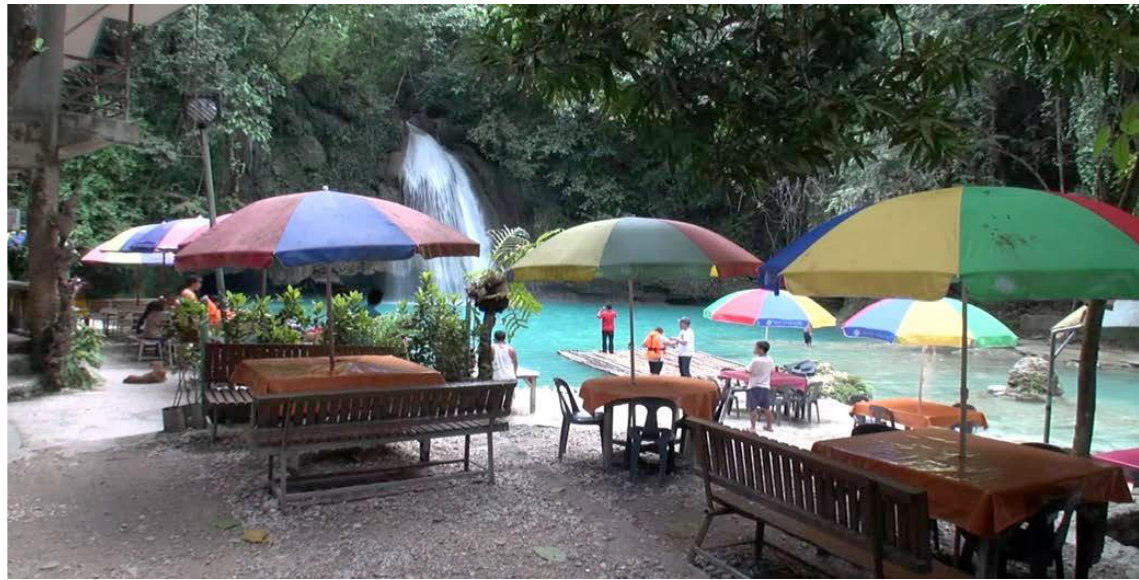
Figure 3. Showing the mess hall area located near the clean water of Kawasan